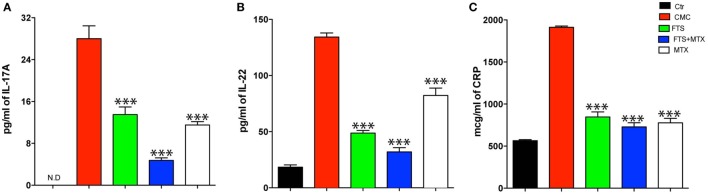
Farnesylthiosalicylic acid (FTS) treatment reduces serum Th17-cytokines and CRP levels during arthritis development. Sera from rats treated with carboxymethyl cellulose (CMC), FTS, FTS + MTX, or MTX was collected at Day 14 post adjuvant injection (day +3 from arthritis onset) and analyzed for (A) IL-17A, (B) IL-22, and (C) CRP levels by ELISA kits. Bars represent mean ± SD of triplicates from a representative experiment out of three performed (n = 4 rats analyzed per group). ND, not detectable. Statistical significance among groups was analyzed by the Student’s t-test (*P ≤ 0.05, **P ≤ 0.01, and ***P ≤ 0.001).